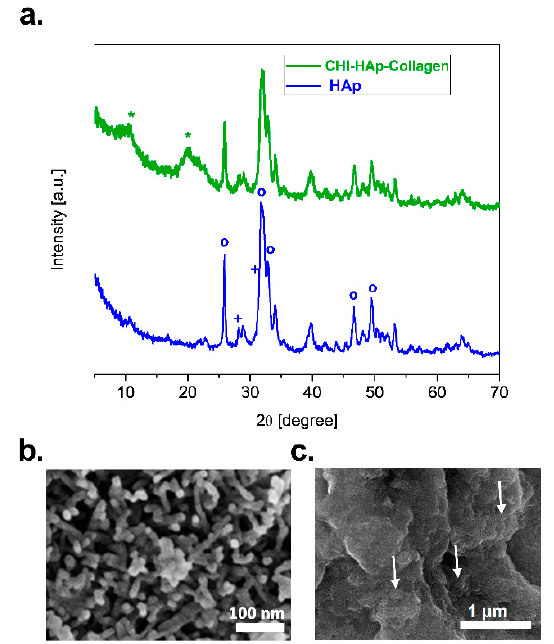
Figure 1. The analysis of ( a ) XRD pa tt erns of HAp powder (O—HAp, +—TCP) and CHI–HAp–collagen (*—CHI). ( b ) FE-SEM of HAp powder and ( c ) FE-SEM of CHI–HAp–collagen (arrows show HApNPs).